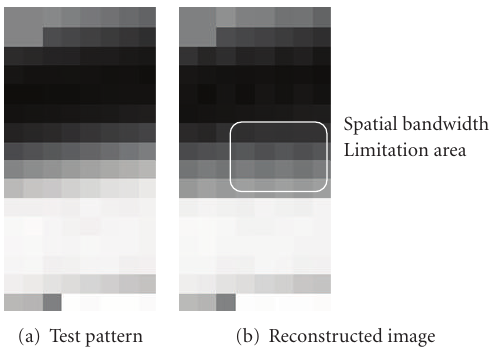
Figure 9: Measured input test image and reconstructed